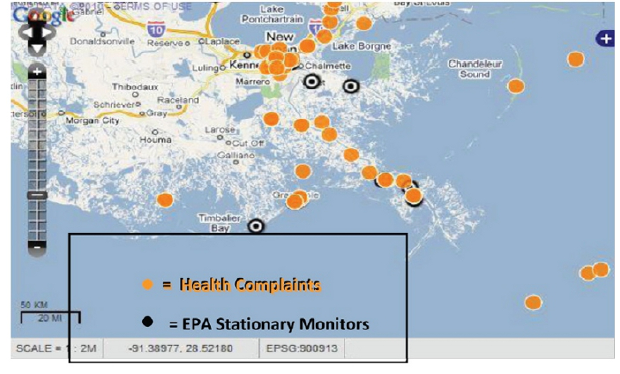
Fig. 1 . Comparison of EPA Air Monitoring Sites and LABB Map Reports (Source: LABB